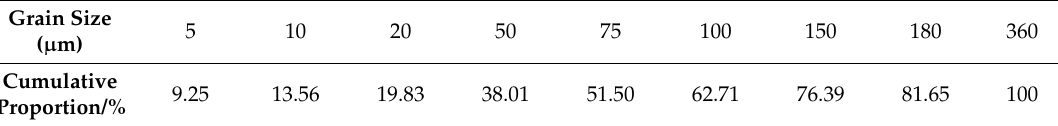
Figure 1. The full tailings, from the Lilou Iron Mine, used during CWRTB sample preparation.